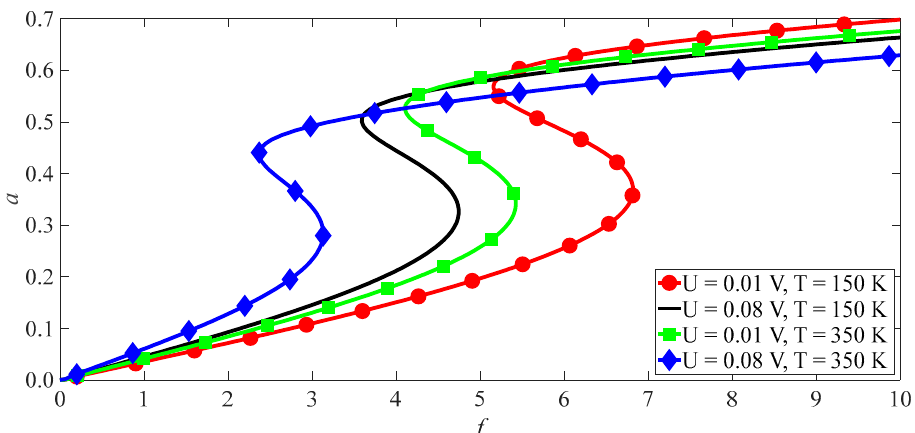
9 of 18 Figure 6. Frequency − response curves of the first mode with (